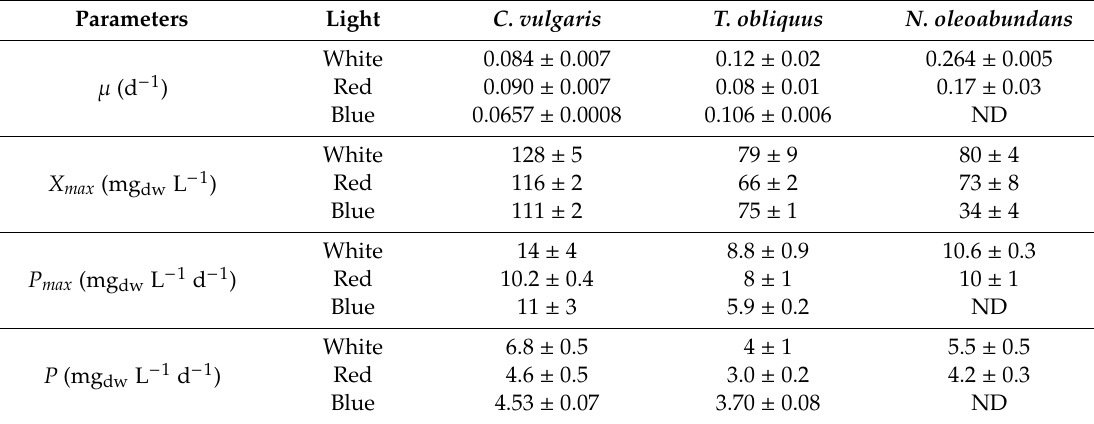
Table 2. Kinetic growth parameters determined for the studied microalgae grown under di ff erent light